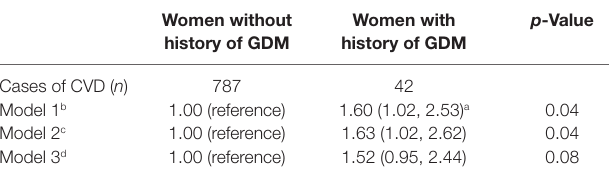
TaBle 2 | Association between history of GDM and risk of CVD among parous women.